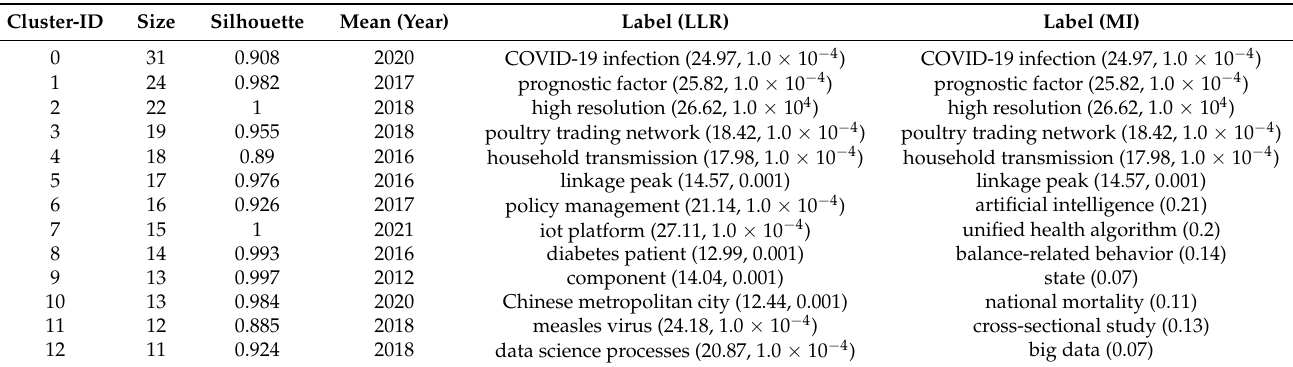
Table 10. A brief summary of the top 12